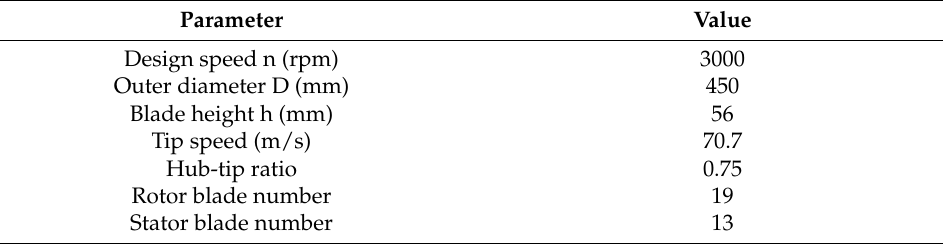
Table 1. Brief introduction of the geometric parameters.